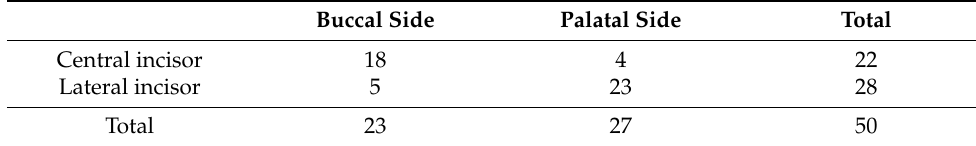
Table 1. Distribution of radicular grooves.